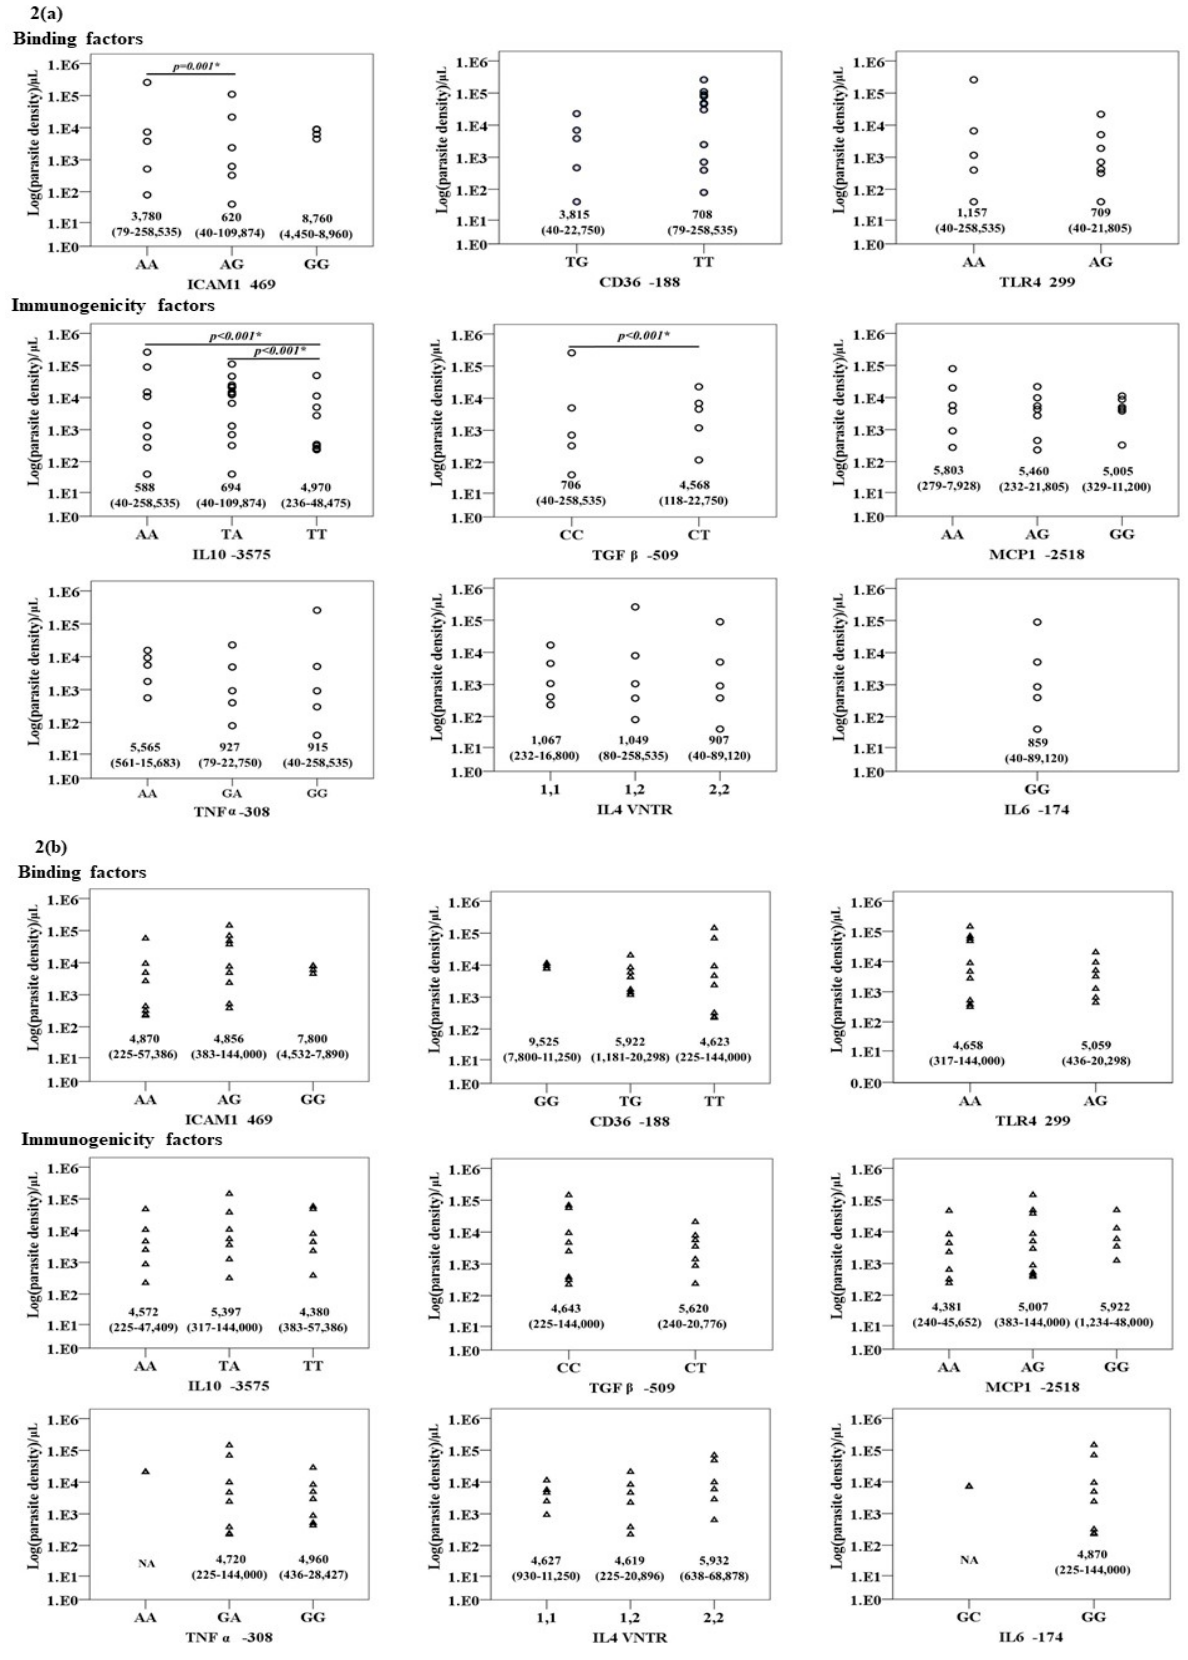
Figure 2. The relationship between the genotypes of the nine genes under investigation and Log ( parasite density ) (/µL) in ( a ) P. falciparum and ( b ) P. vivax infections.